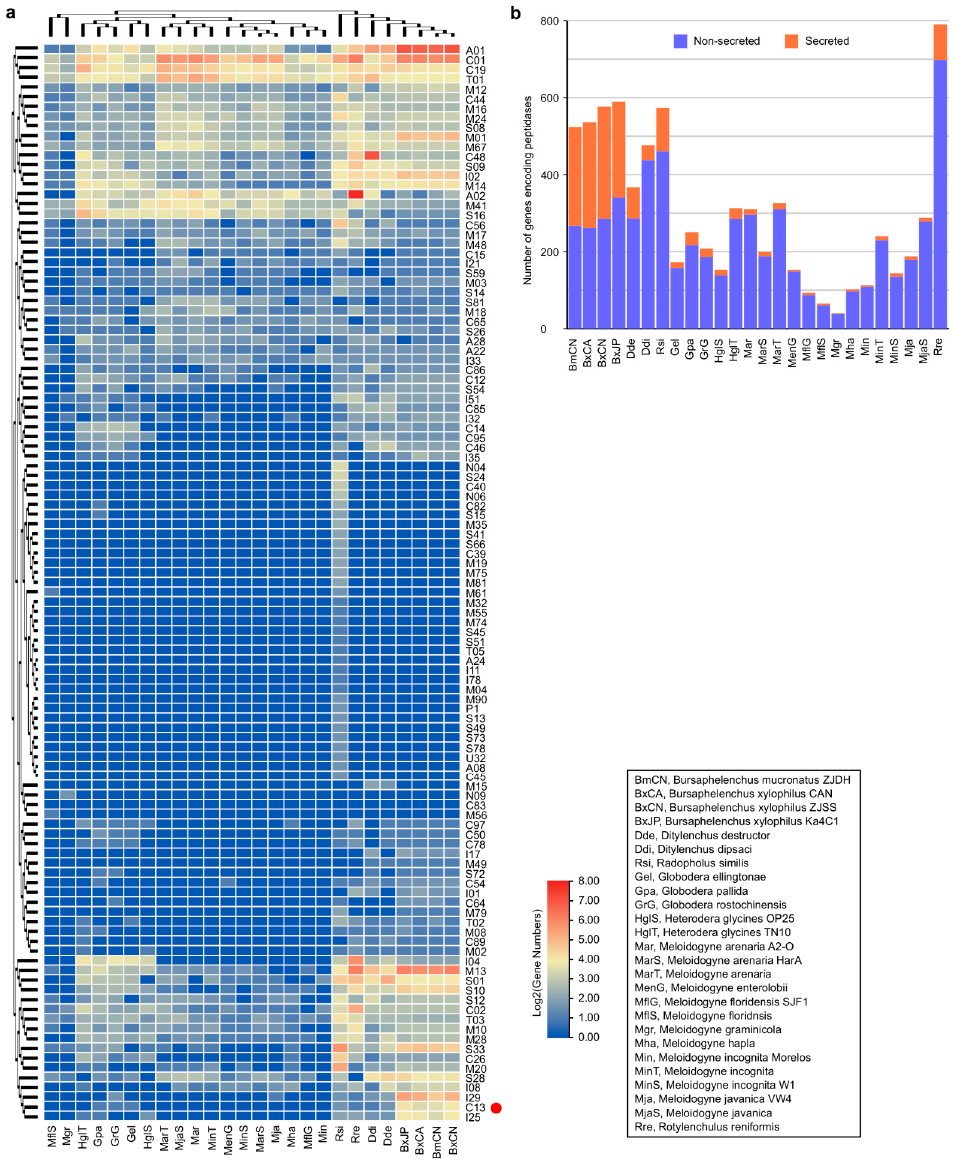
Figure 1. Predicted genes encoding peptidases in plant-parasitic nematode genomes: ( a ) heatmap of peptidases distribution. The red dot marks the peptidase C13 family (legumains); ( b ) number of peptidases in each genome.